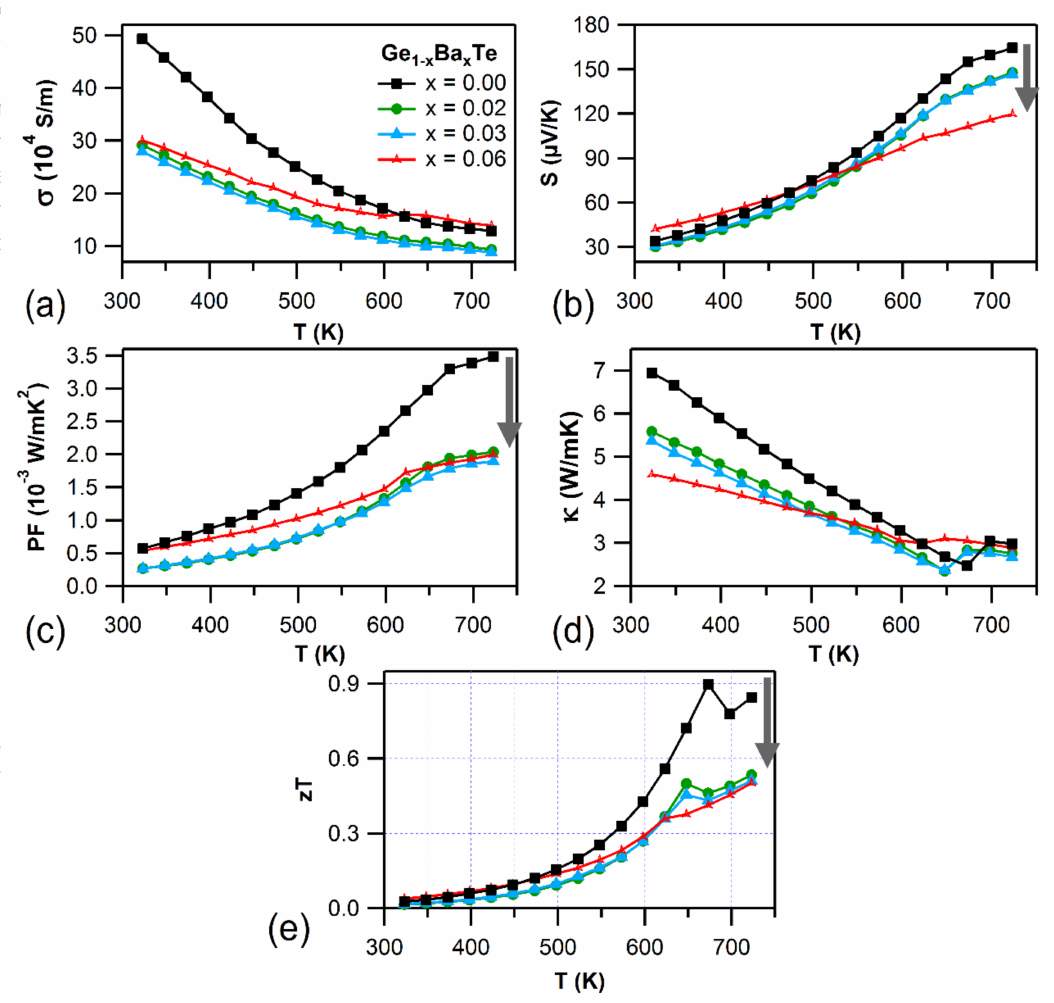
Figure 3. Temperature-dependent ( a ) electrical conductivity ( σ ), ( b ) Seebeck coefficient ( S ), and ( c ) power factor (PF = S 2 σ ), ( d ) total thermal conductivity ( κ ), and ( e ) figure of merit ( zT ) for Ge 1 − x Ba x Te ( x = 0.00–0.06)